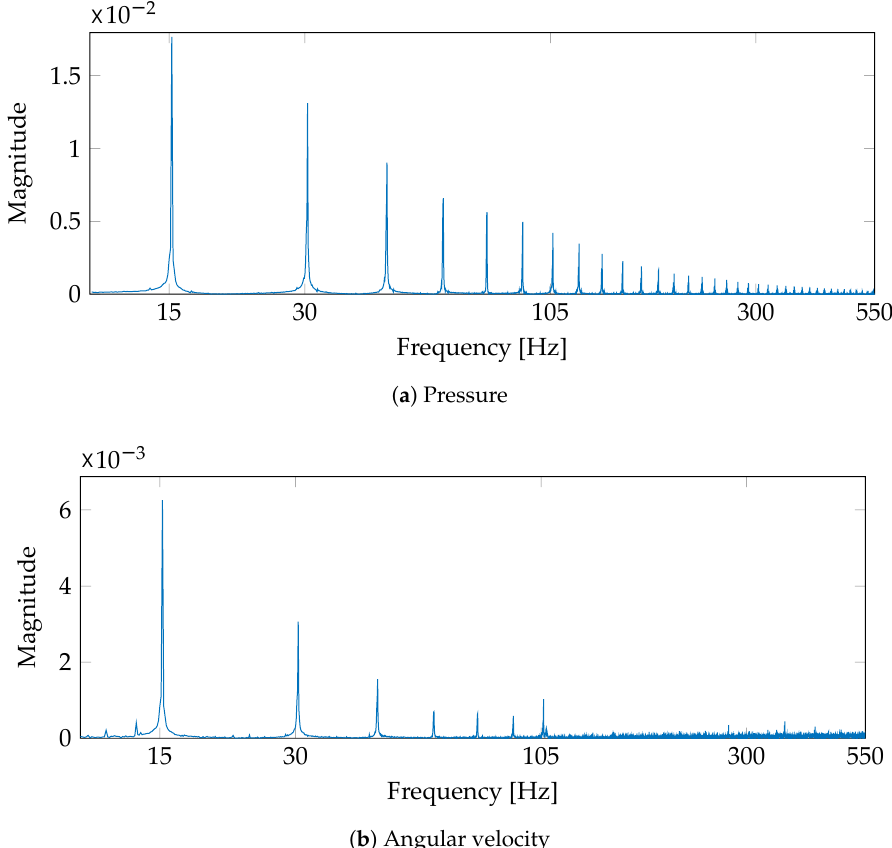
Figure 5. Spectrum magnitude of the pressure and angular velocity signals depicted in Figure 4 (the engine velocity and load are fixed to 1800 RPM and 3.22 BMEP, respectively). The amplitude is normalized concerning the first harmonic power. The horizontal axis is on a logarithmic